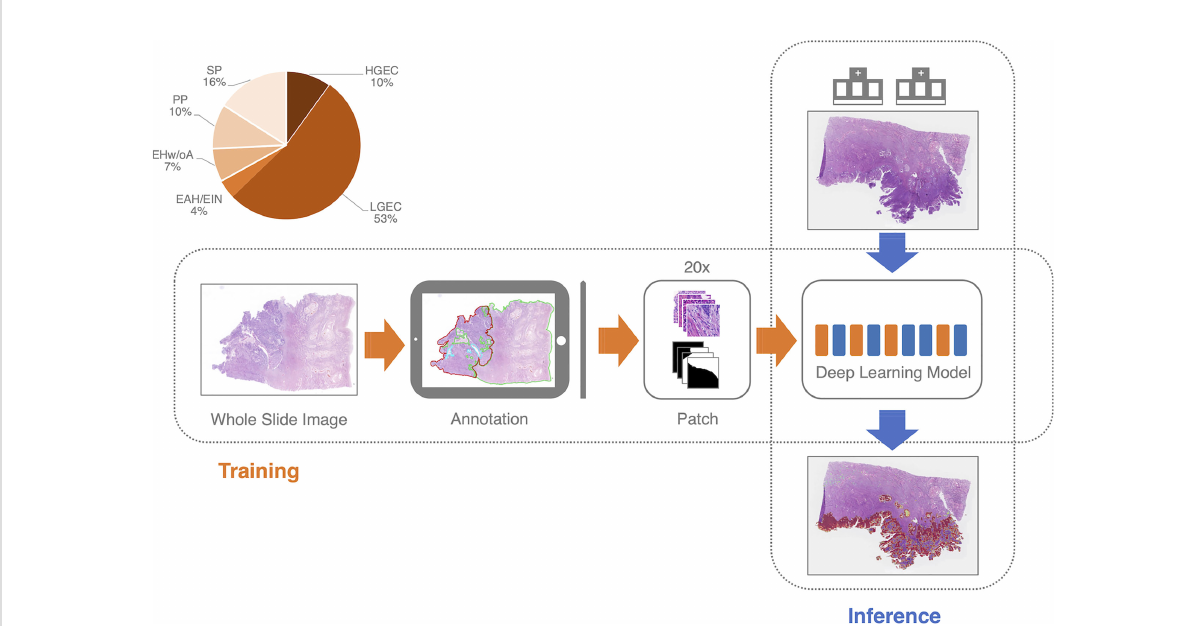
FIGURE 3 The training and inference pipeline of the deep learning model. EC, endometrial cancer; SP, Secretory phase; PP, Proliferative phase; EHw/oA, Endometrial hyperplasia without atypia; EAH/EIN, Endometrial atypical hyperplasia/Endometrioid intraepithelial neoplasia; LGEC, EC (low-grade); HGEC, EC